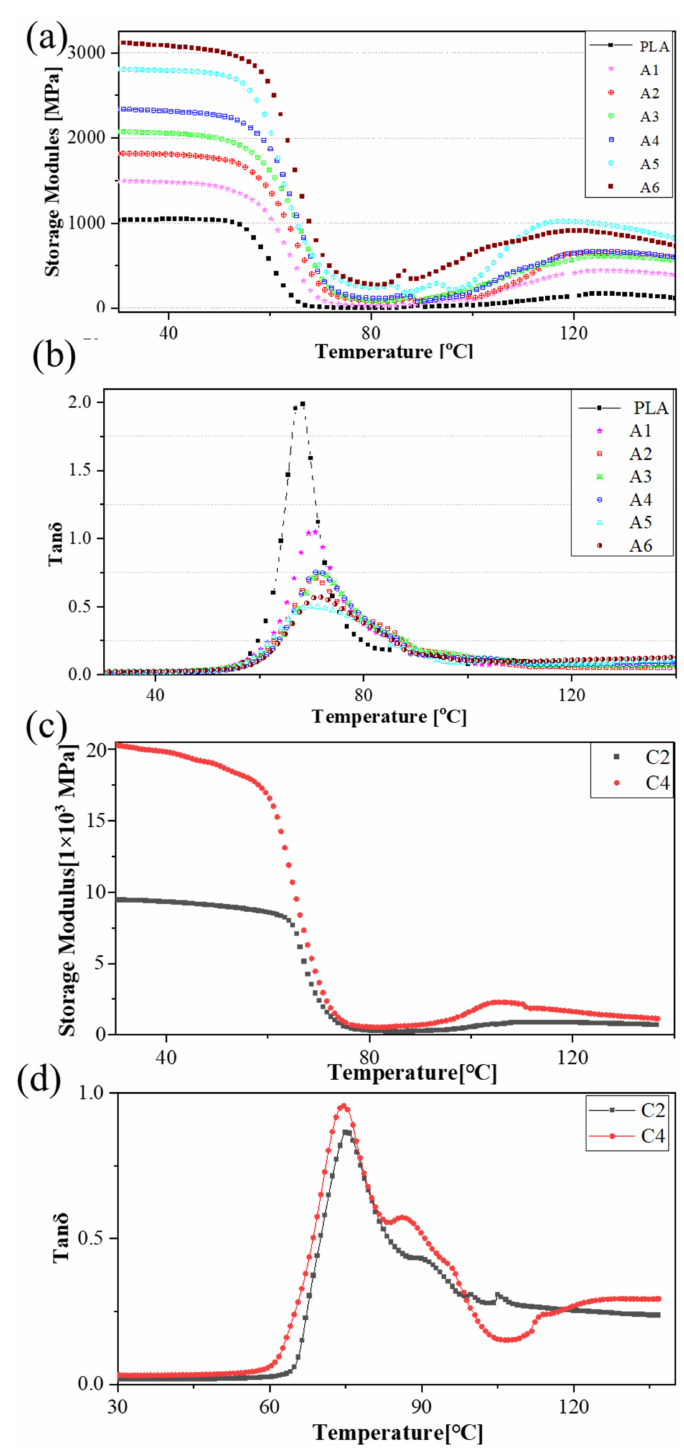
Figure 5. The mechanical properties of the polymers with a focus on the thermal endurance properties: ( a ) the storage modulus and ( b ) tan δ curves of group A, and ( c ) the storage modulus and ( d ) tan δ curves of C2 and